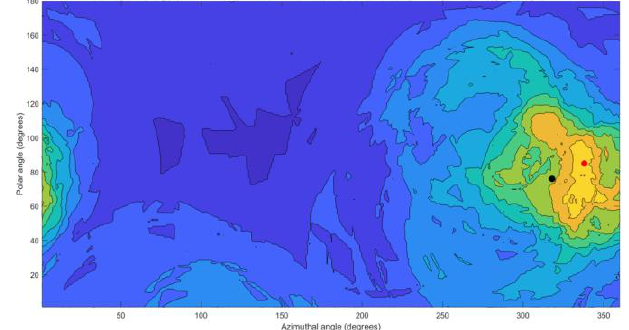
Fig. 12. Demonstration of cone down-selection using source direction guess vector region. All cones that do not overlap the region oullined in black in the first image are removed to form the improved image.